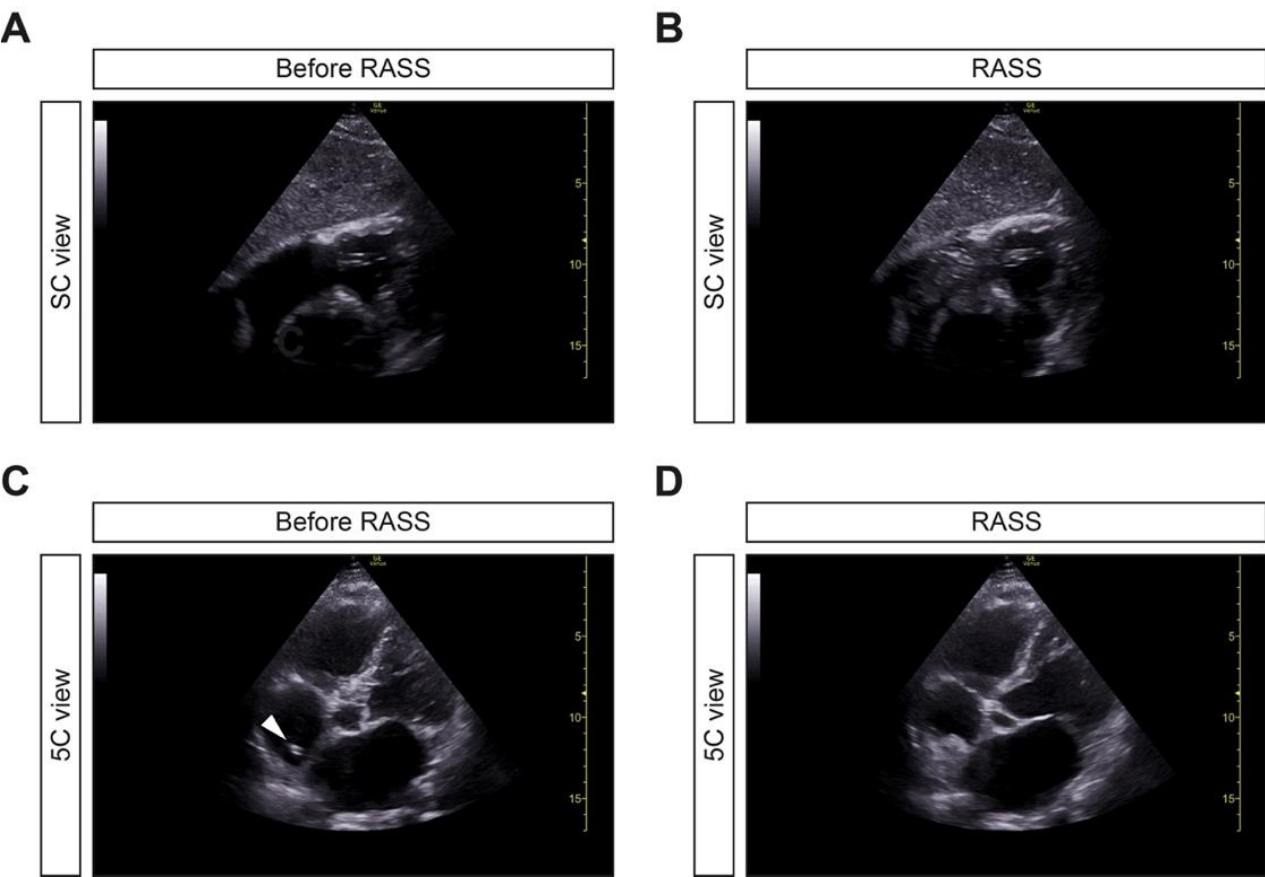
Figure 2. Application of the RASS for US-guided tip positioning of retrograde-tunneled HDCs. ( A , B ) After placement of the retrograde-tunneled HDC, focused echocardiography using a SC view to visualize the right atrium and RASS was performed. If the RASS appeared immediately, within one second, HDC tip positioning was considered to be adequate. ( C , D ) The HDC positioning was considered to be in the adequate position if the tip was visualized within the right atrium (arrowhead), with reconfirmed immediate RASS visualization in the apical 5C view, within one second. Abbreviations: HDC, hemodialysis catheter; RASS, rapid atrial swirl sign; SC, subcostal; US, ultrasound; 5C, five-chamber. The overall success rate of applying the RASS for US-guided tip positioning of retrograde-tunneled HDCs was 24/24 (100%), with proper tip position in the right